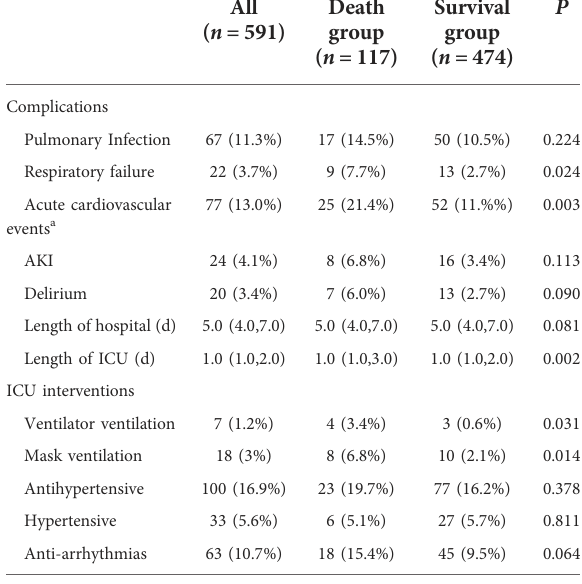
TABLE 2 Postoperative complications and ICU